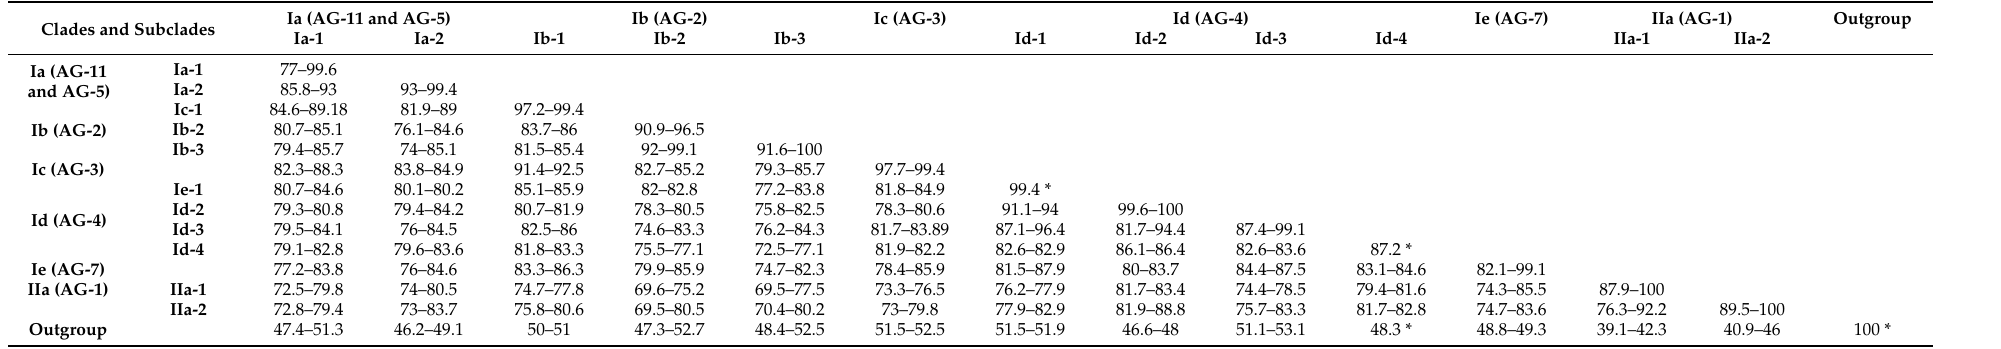
Table 2. Percentages of sequence similarities of rDNA-ITS sequences of R. solani AG within and between clades and